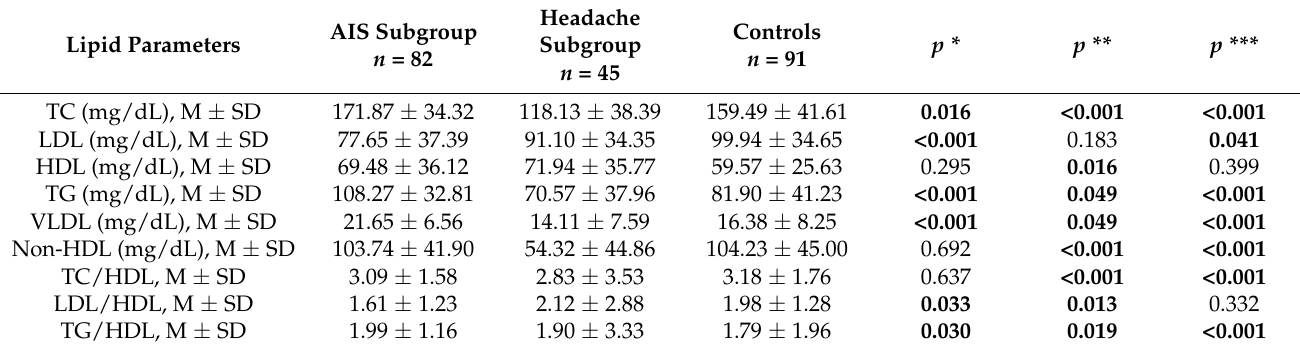
Table 2. Levels of lipid parameters in all analyzed pediatric